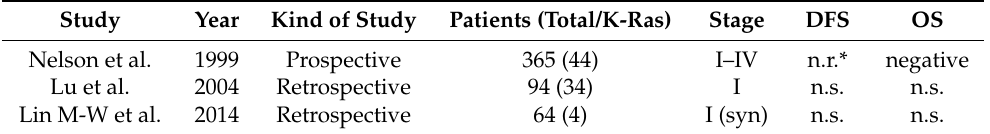
Table 3. Disease-free survival (DFS) and overall survival (OS) in early-stage NSCLC with KRAS expression. Study Year Kind of Study Patients